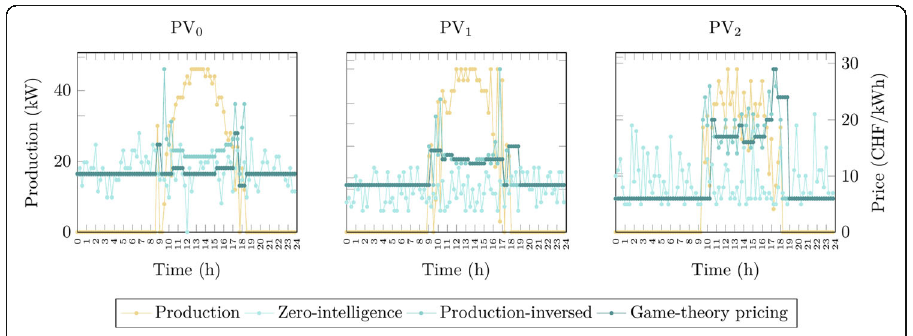
Fig. 4 Price profiles of each PV under three types of pricing